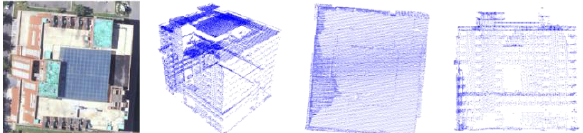
Figure 1. Airbore LiDAR point cloud. The perspective view (left), top view (middle), and side view (right) of point cloud.